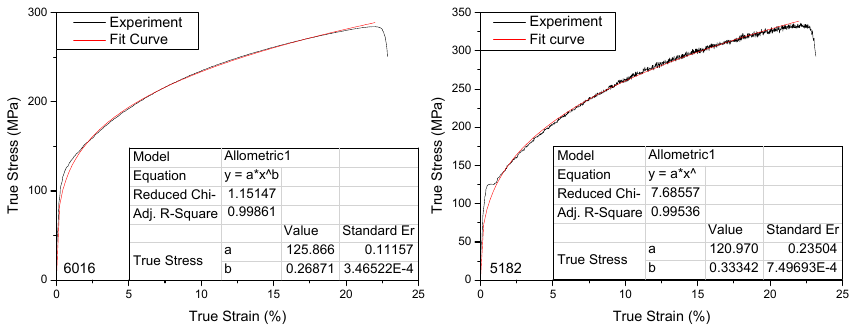
Figure 4. The stress-strain response of AA6016 and AA5182. Table 1. Material parameter of AA6016 and